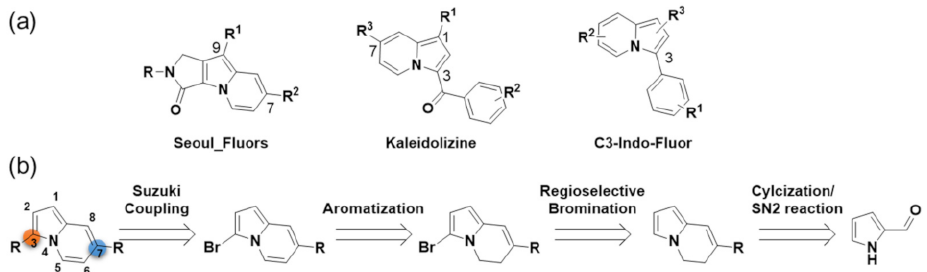
Figure 1. ( a ) Indolizine-based fluorescent core skeletons. ( b ) Retrosynthetic analysis for the 3,7- disubstituted new indolizine-based fluorescent skeletons under